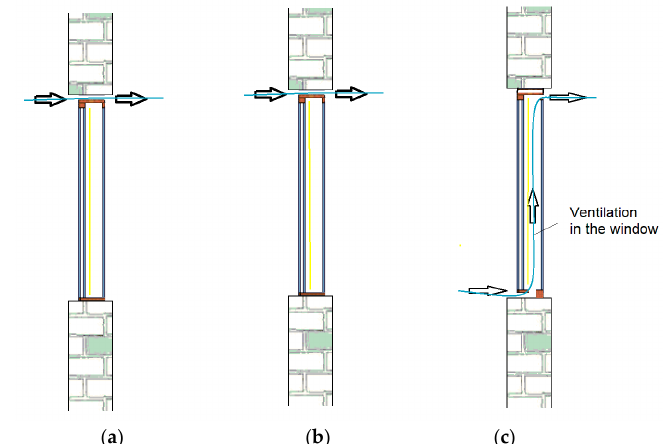
Figure 11. Summer reference case 1 using VW [14]. ( a ) Night time ventilation, when (hour < 7) or (hour > 20:00). ( b )Bypass ventilation , when T indoor > 24 °C . ( c ) Heat mode, when T indoor < 24 °C .